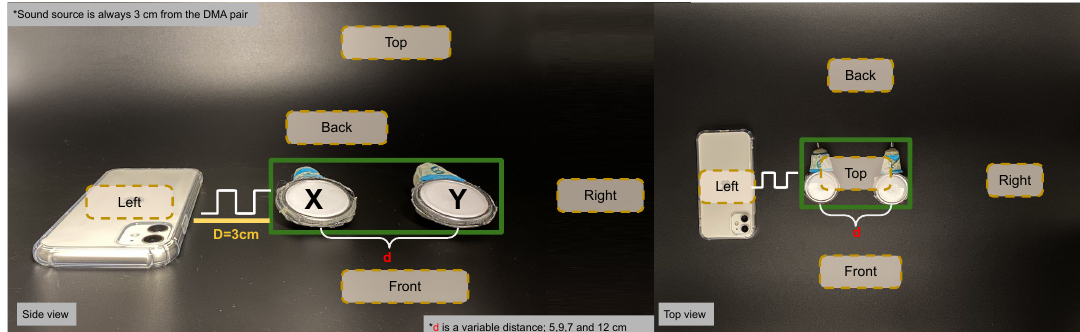
Figure 7. Calibration showing sound-source (phone) at 3 cm from DMA; microphone “X” and microphone “Y” with a variable inter-microphone distance “d” (5, 7, 9 and 12 cm). Frequency range of the sound square wave with 20 s duration at each frequency and for each source position (back, right, left, top and front).